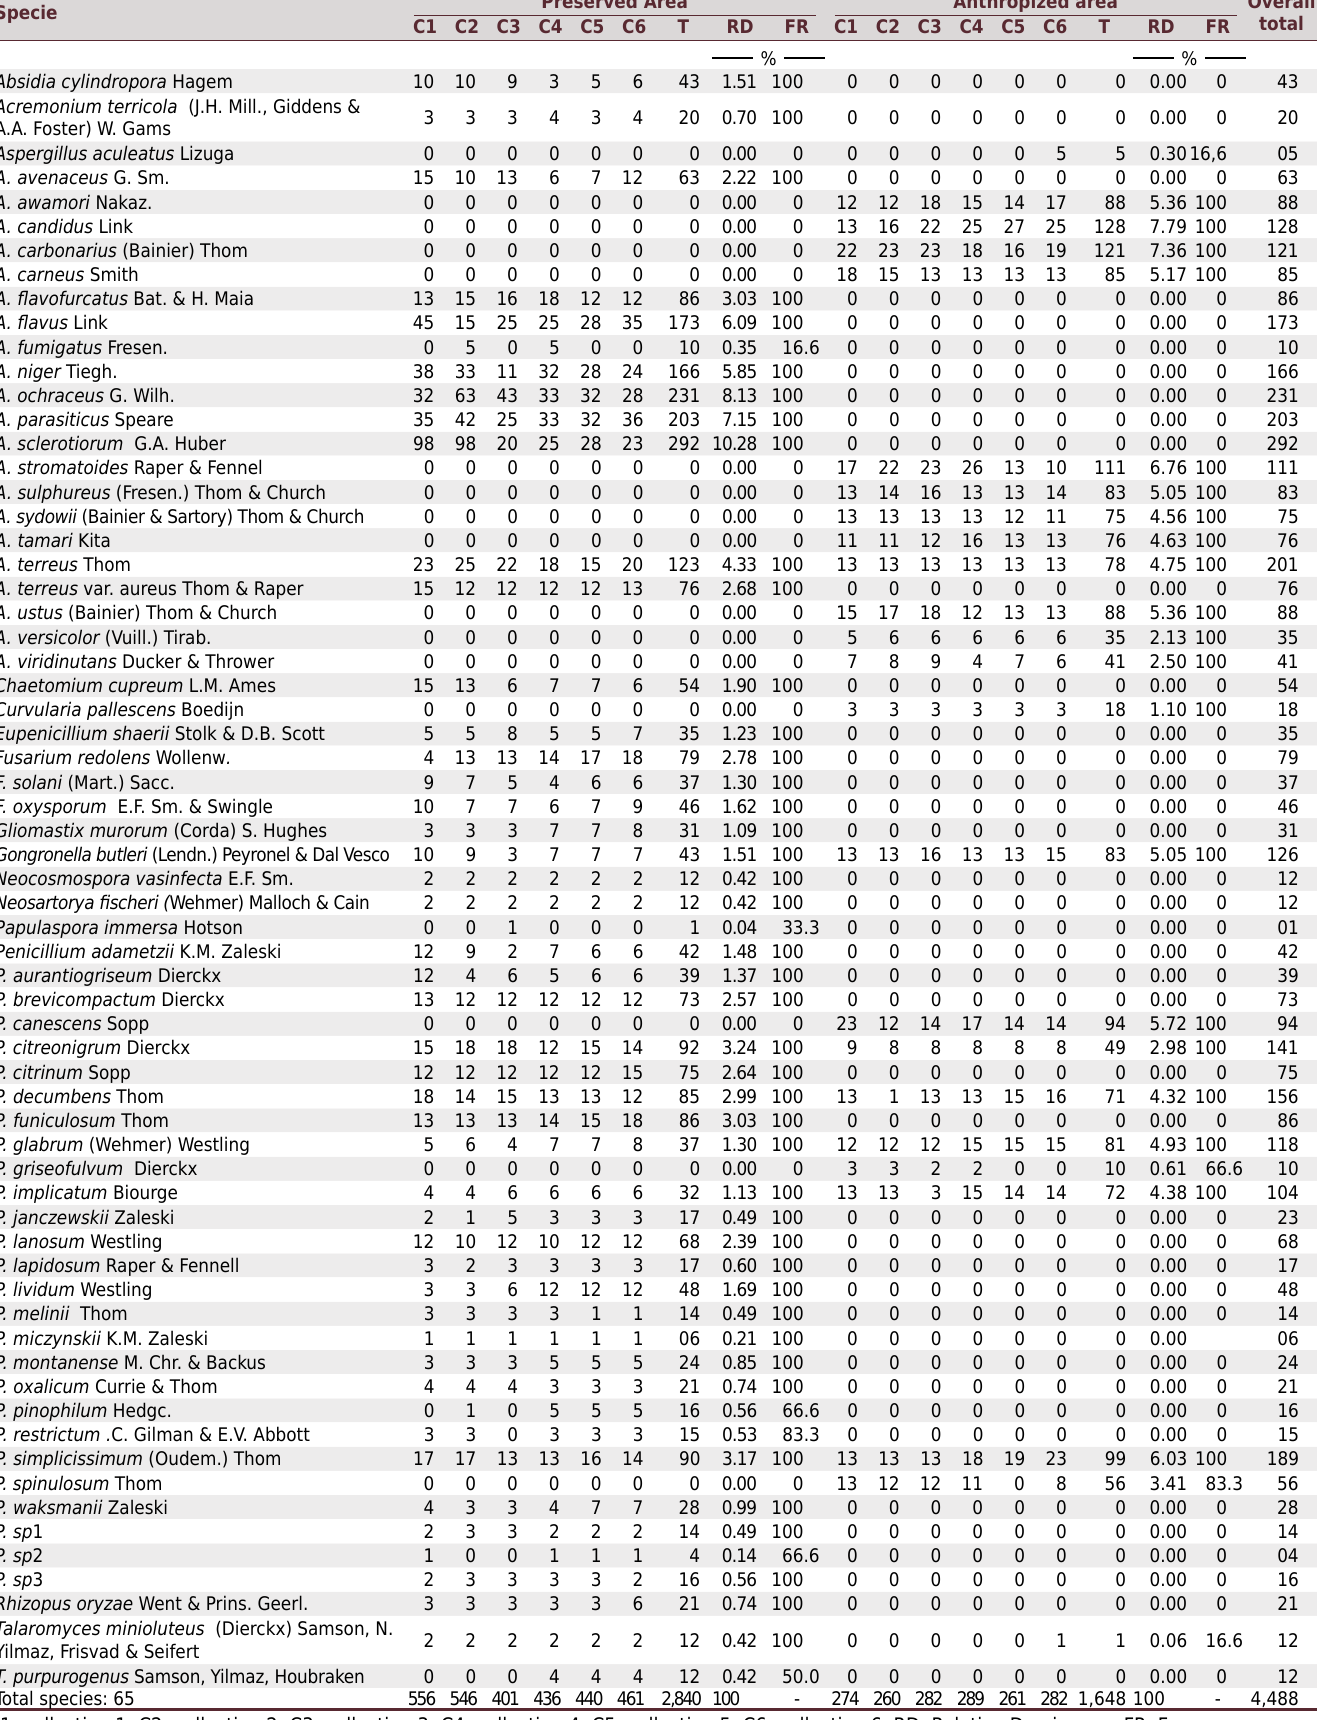
Table 2. Number of filamentous fungal isolates collected in the preserved and anthropized areas of the PARNA Catimbau (Caatinga) and Relative Dominance, according to Magurran (1988).